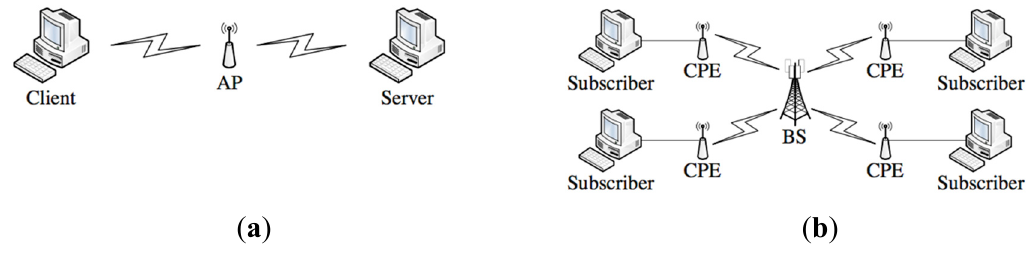
Figure 6. Short-medium distance topology: ( a ) WiFi test; ( b ) WiMAX test.